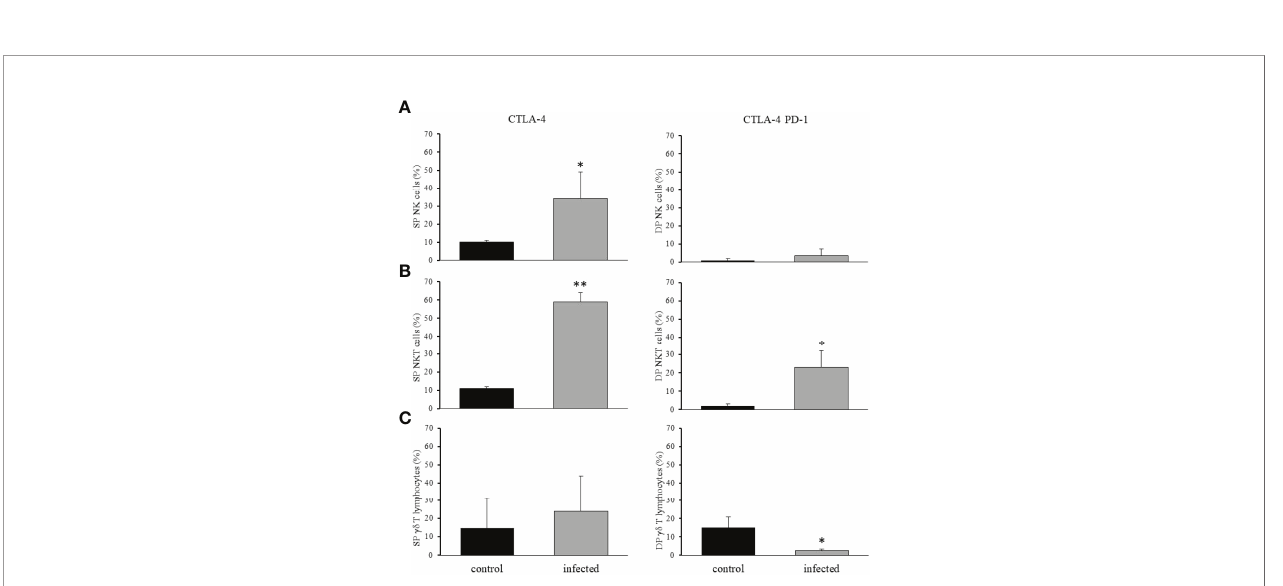
FIGURE 8 | Expression of immunomodulatory molecules by NK, NKT, and gd T lymphocytes. The intrahepatic cells were isolated from control and T. cruzi infected mice on dpi 15, and NK (A) , NKT (B) , and gd T lymphocytes (C) were analyzed. CTLA-4 single positive cells (left panels) or PD-1 and CTLA-4 double-positive cells (right panels) are shown. * means p ≤ 0.05 and ** means p ≤ 0.005. We used the one-way ANOVA test for NK and NKT cells followed by the Tukey ’ s post-test, and for gd T lymphocytes, we used the Kruskal Wallis test followed by the Dunn ’ s post-test.